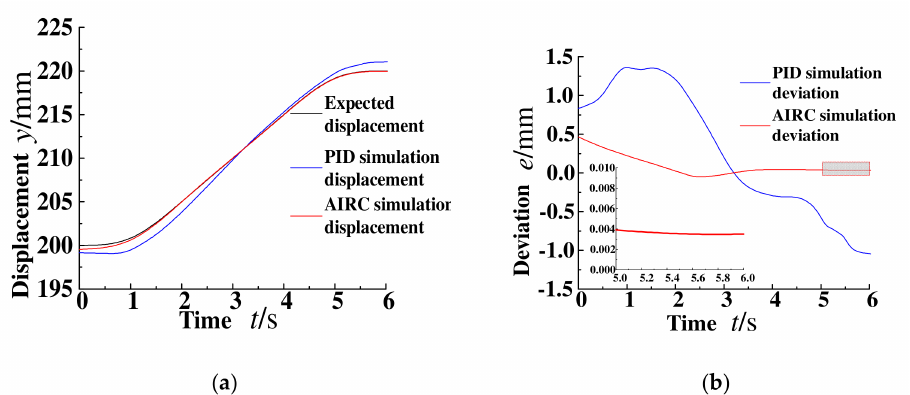
Figure 6. System displacement and deviation curve under working condition 1 (cid:13) . ( a ) System displace- ment curve. ( b ) System displacement deviation curve.